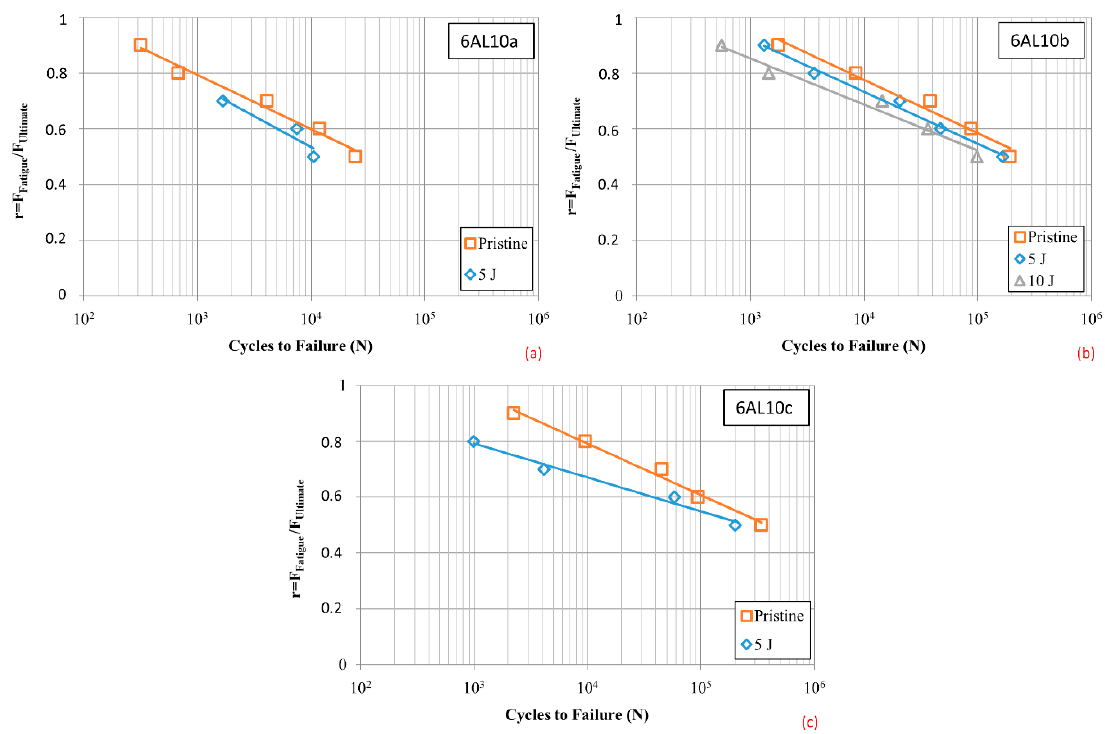
Figure 7. Loading ratio vs. cycles to failure graphs for ( a ) 6AL10a, ( b ) 6AL10b and ( c ) 6AL10c specimens.